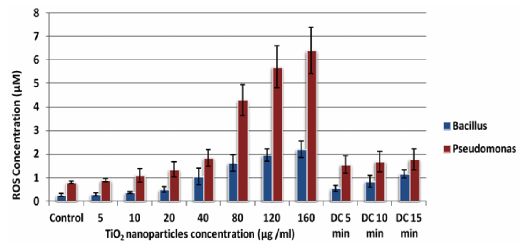
Figure 10: The effect of TiO 2 -NP concentrations (5-160 µ g/mL) and DC exposure (5, 10, and 15 min) on the ROS concentration ( µ M) of B. cereus and P. aeruginosa